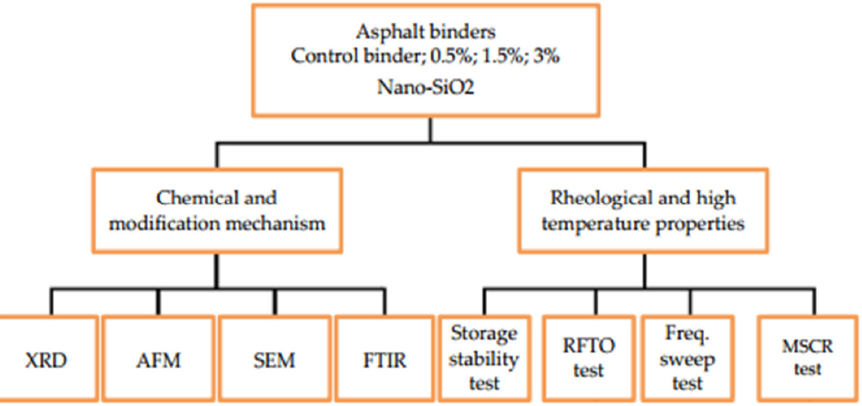
Figure 3. Experimental flow chart utilized herein.